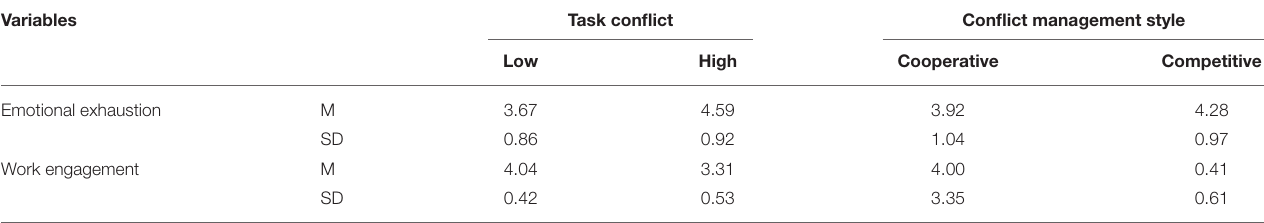
TABLE 6 | Descriptive statistics for task conflict and conflict management style ( N = 60).